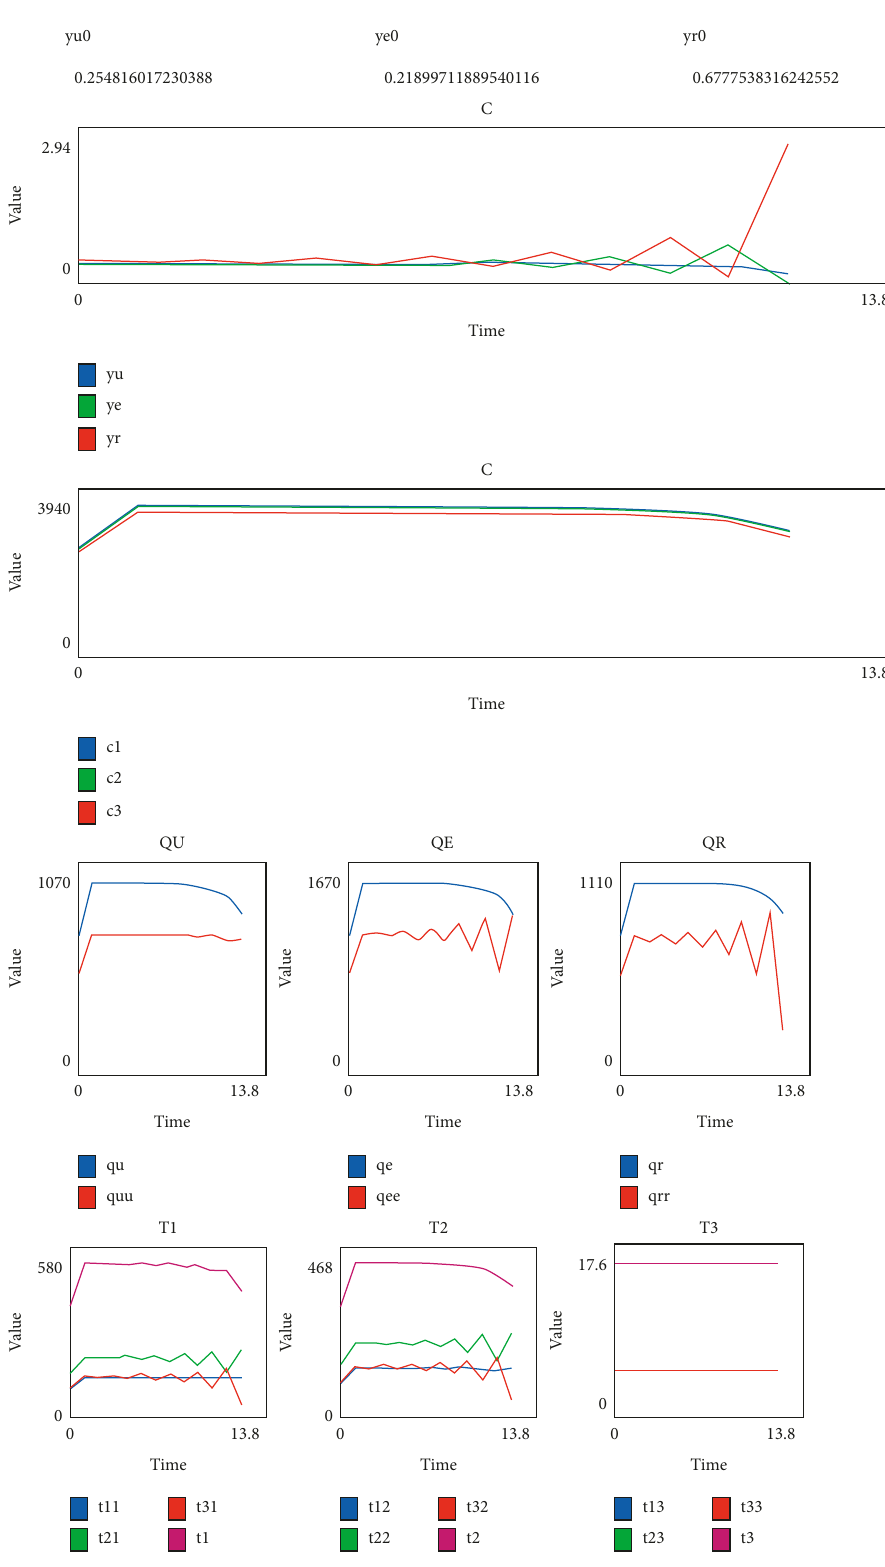
Figure 4: Simulation results of scenario